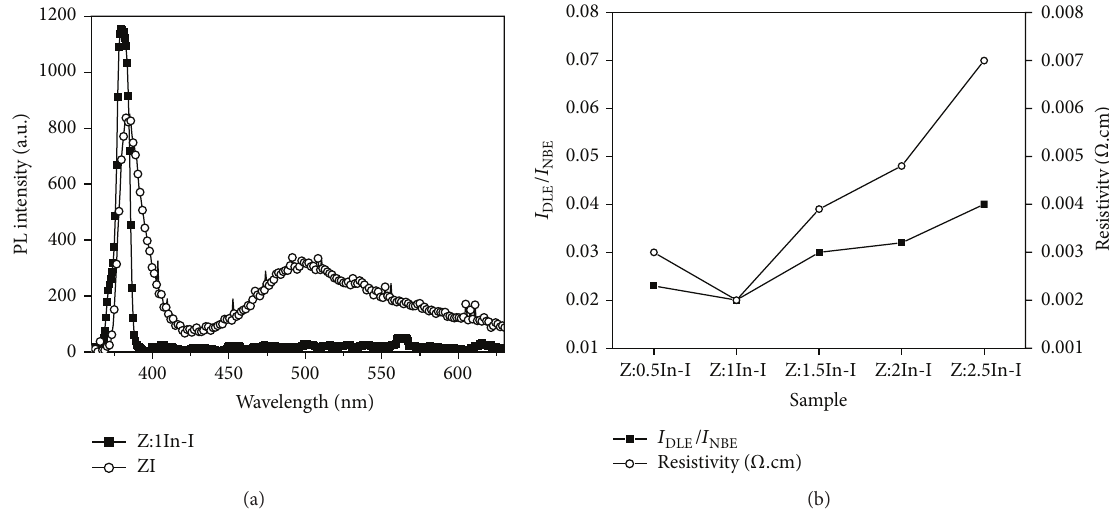
/𝐼 and resistivity with indium doping in ZnO thin DLE NBE